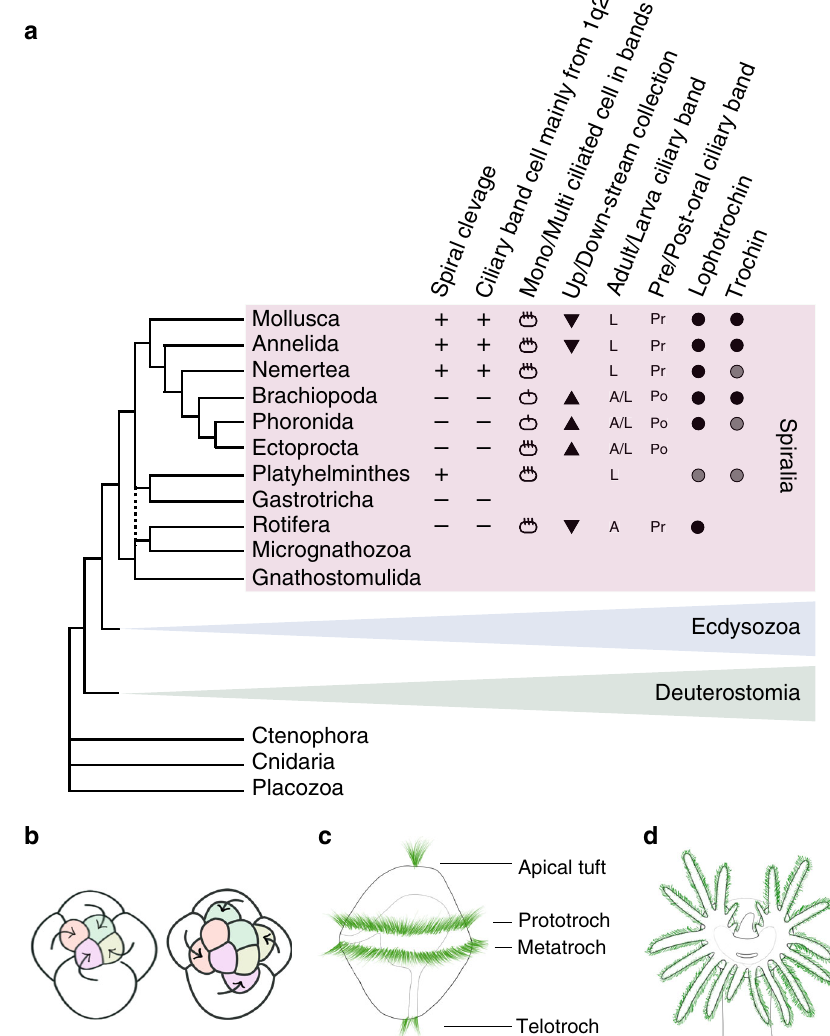
Fig. 1 The clade Spiralia and spiralian development. a Phylogeny of the Spiralia within the Metazoa, with key characters indicated, focusing on those related to the ciliary bands 2 – 6 . The characters describe the generalized differences among groups, but not necessarily true for all the members within the group. The prototroch of molluscs, annelids, and basal nemerteans is derived from the vegetal daughters of the fi rst quartet of micromeres (1q 2 ), supporting homology. This is not true for other spiralians; in most groups spiral cleavage has been lost, so it is not possible to identify the equivalent cells, even if fate-mapping studies have been performed. Platyhelminth fl atworms do have spiral cleavage but the contribution of their 1q 2 cells has not been speci fi cally determined, so cell lineage does not support the homology of fl atworm larvae ciliary bands with molluscs, annelids and nemerteans. Cell symbol with one line: monociliated cell in bands; cell symbol with multiple lines: multiciliated cell in bands. Triangle orientation indicates whether the ciliary bands in the group collect food particles upstream or downstream 23 . L: larva ciliary band; A/L: adult and larva ciliary band Pr: preoral ciliary band; Po: post- oral ciliary band. Black dots indicate where the gene was recovered and in situ performed; gray dots indicate where the gene was recovered in the phylum but we were unable to perform the in situ hybridization. No dot shown indicates the gene was not recovered; in the case of Rotifera, the gene was not recovered in its genome, in all other cases, no genome is available for the search. b Spiral cleavage, characterized by the highly stereotypical angles of the cell divisions, and the characteristic asymmetries in the size of daughter cells. Left panel shows orientation of cell cleavages that give rise to the fi rst set of micromere daughters at the eight-cell stage, and the right panel shows the birth of the second set of micromeres. c A generalized trochophore larva, prototroch and other ciliated structures in green. d Lophophore of an adult lophophorate, cilia in